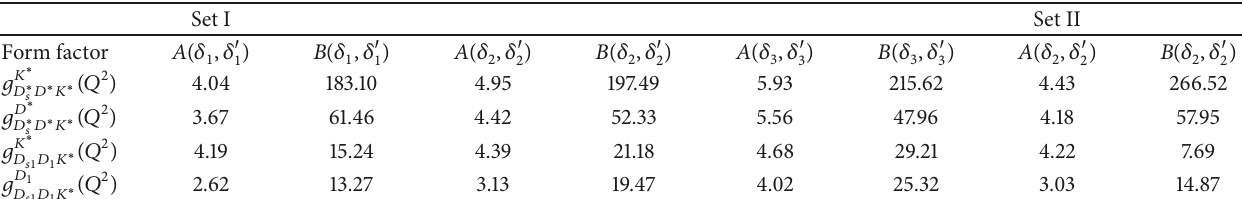
Table 1: Parameters appearing in the fit functions for the 𝐷 ∗ 푠 𝐷 ∗ 𝐾 ∗ and 𝐷 푠1 𝐷 1 𝐾 ∗ vertices for various 𝑚 푐 and (𝛿,𝛿 耠 ) , where (𝛿 1 ,𝛿 耠 1 ) = (0.50,0.30), (𝛿 ,𝛿 耠 ) = (0.70,0.50) , and (𝛿 , 𝛿 耠 ) = (0.90,0.70) GeV. 2 3 2 3 Set